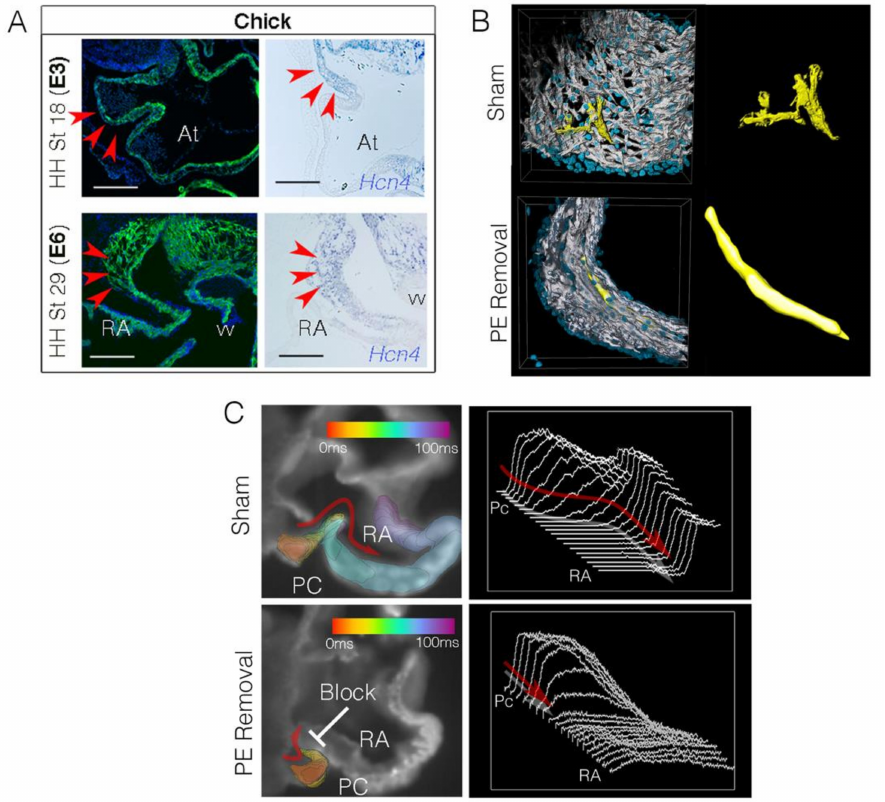
Figure 3. Embryonic remodeling of the sinoatrial node. ( A ) Sections through the chick sinoatrial node at Hamburger Hamilton (HH) stage 18 [121] equivalent to embryonic day 3 (E3) and HH stage 29 (E6). Sections are stained with muscle marker MF20 (green) and Dapi (blue). In situ hybridization for the pacemaker cell marker Hcn4 indicates the location of the sinoatrial node (red arrowheads) (re- produced from [105]). Scale bar–200 mm. ( B ) Volumetric reconstructions of the chick sinoatrial node at HH stage 29. Data are shown from a control embryo (Sham) and an embryo in which proepicardial cells have been blocked from entering the sinoatrial node. MF20 − white, Dapi − blue. Groups of pacemaker cells have been reconstructed in yellow to demonstrate the change in morphology when proepicardial cells are prevented from entering the sinoatrial node. ( C ) Isochronal maps of impulse propagation through sections of the sinoatrial node/atrial junction. Following proepicardial removal, sinoatrial node conduction block occurs (reproduced with permission from [104]). PC-pacemaker cells, RA-right